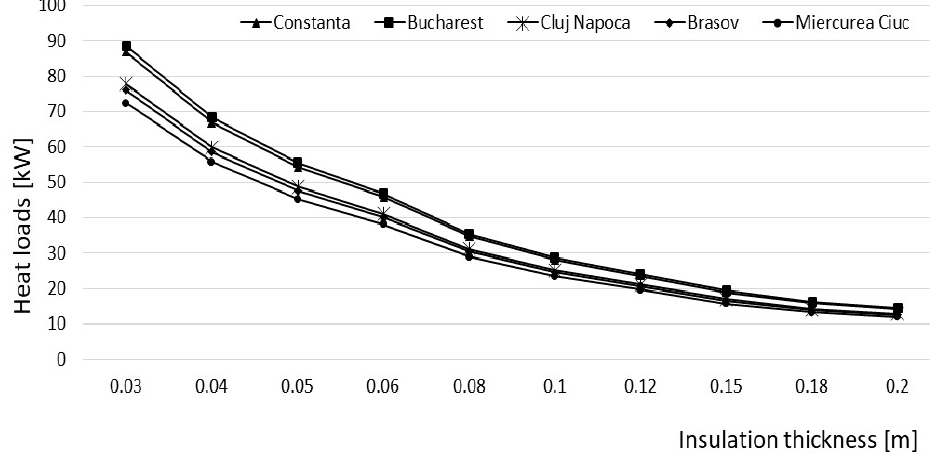
Figure 1. The heat transfer through building parts for cold